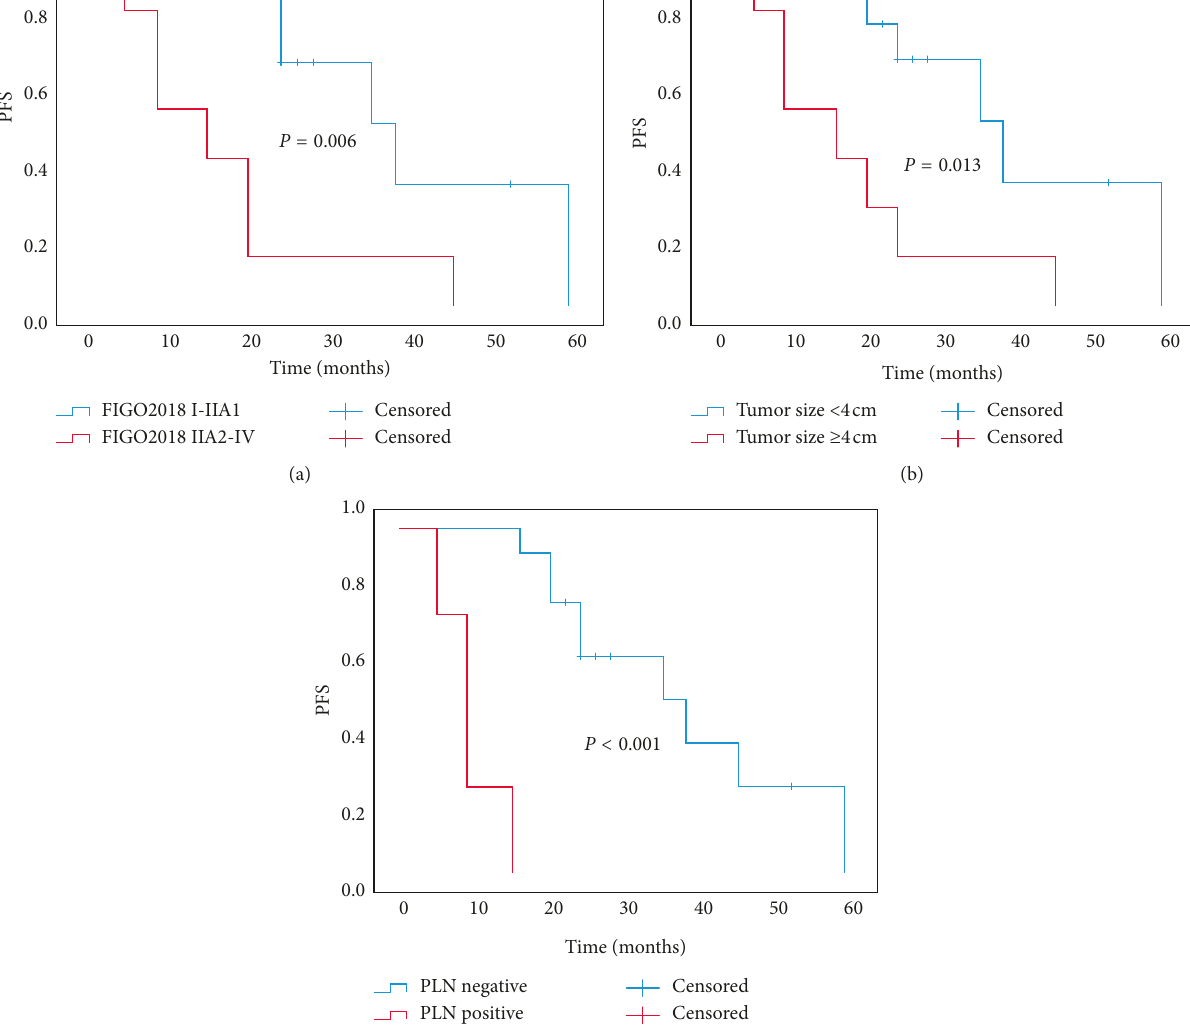
0 . 006). (b) The PFS for tumor size (cid:31) 0 . <